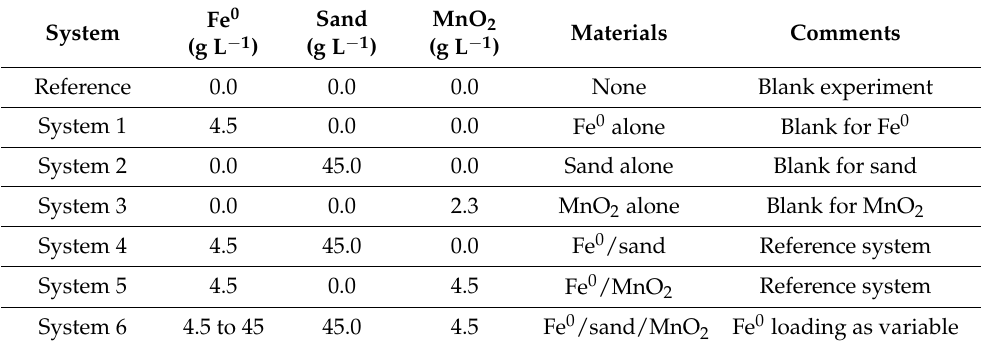
Table 2. Overview of the six (6) investigated systems. The material loadings correspond to Figure